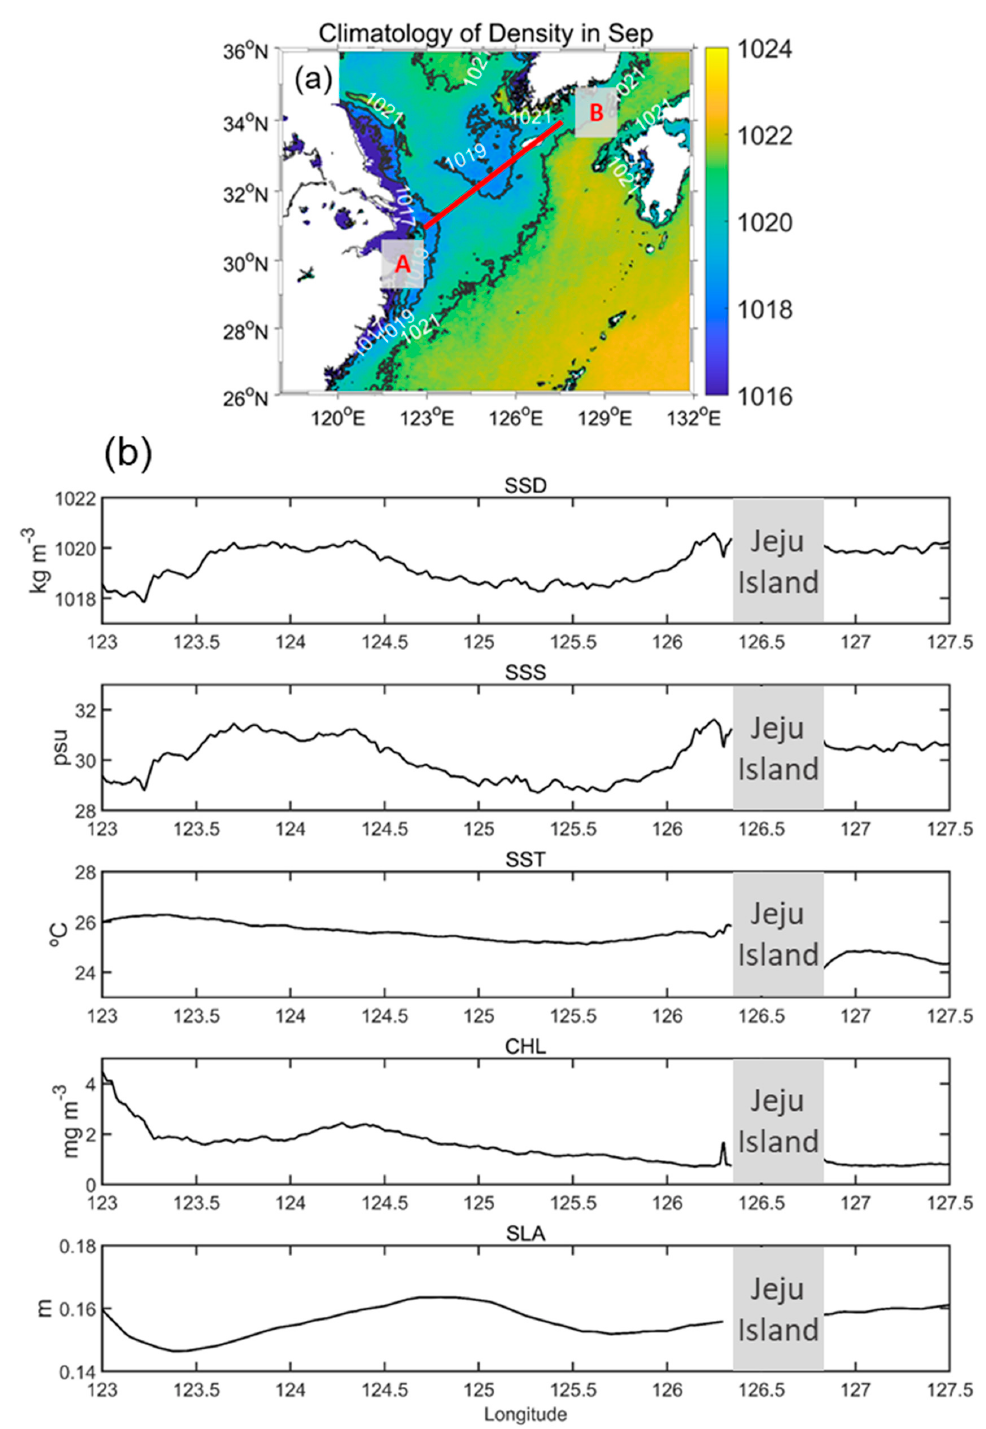
Figure 7. ( a ) SSD climatology during September for 20 years (from 2002 to 2021). ( b ) Climatology for SSD, SSS, SST, Chl, and SLA along the A–B line (red line in ( a )) during September.